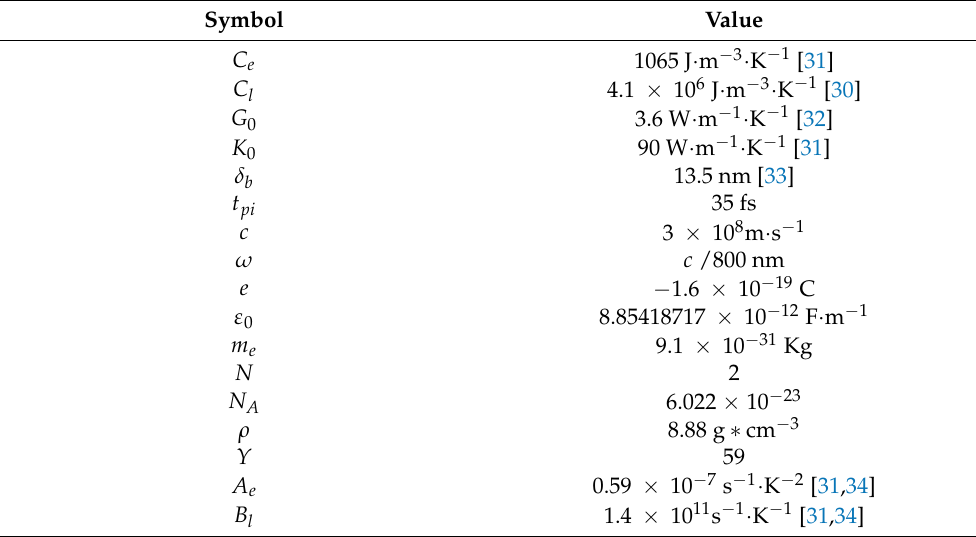
Table 2. The values of various parameters in the